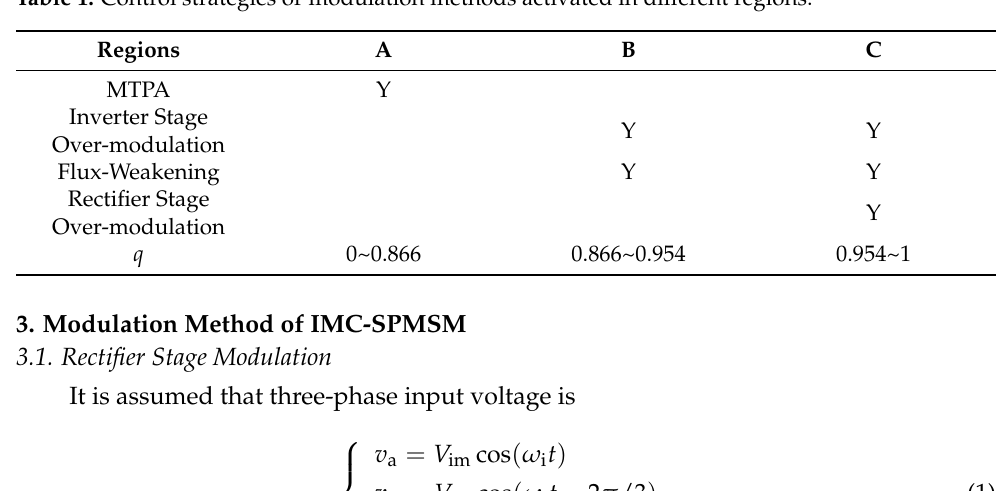
Figure 3. Schematic diagram of rectifier stage modulation section and v pn waveform. ( a ) Rectifier stage modulation section; ( b ) v pn